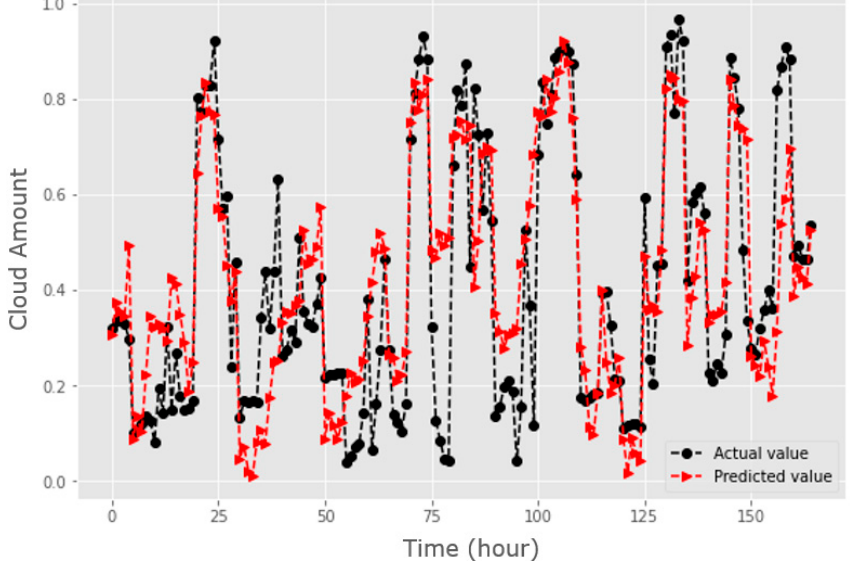
Figure 9. Result of cloud amount forecasting.